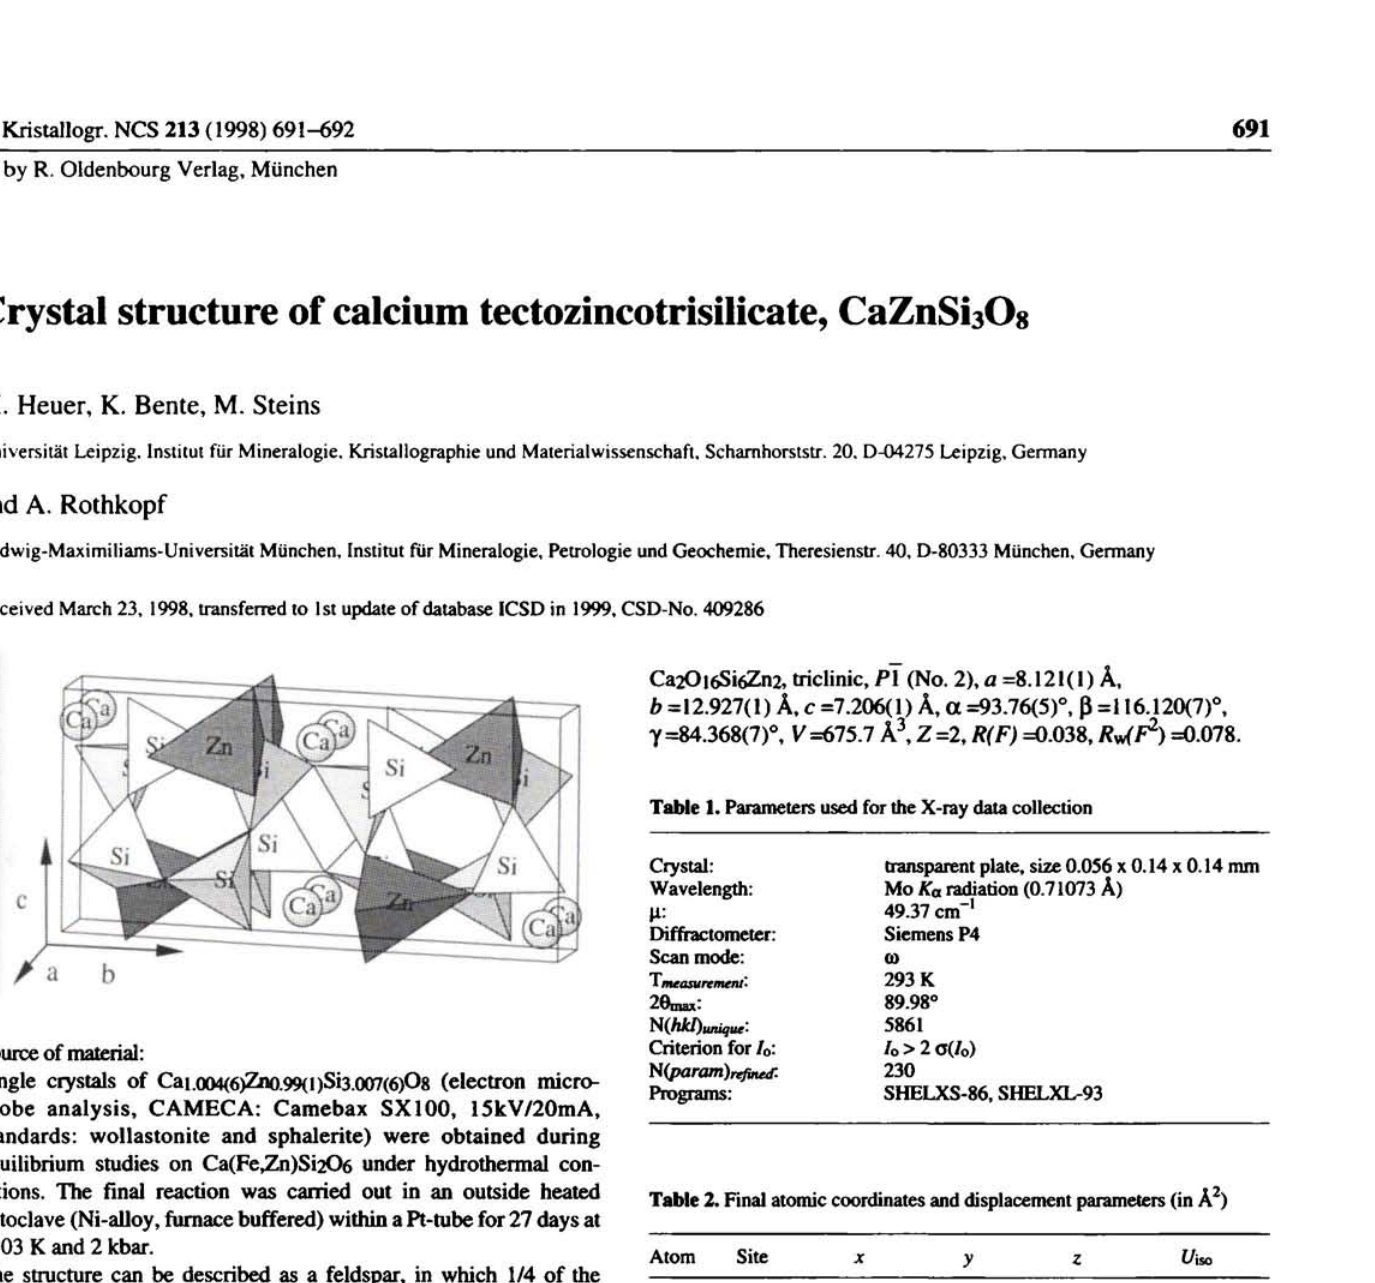
Table 2. Final atomic coordinates and displacement parameters (in